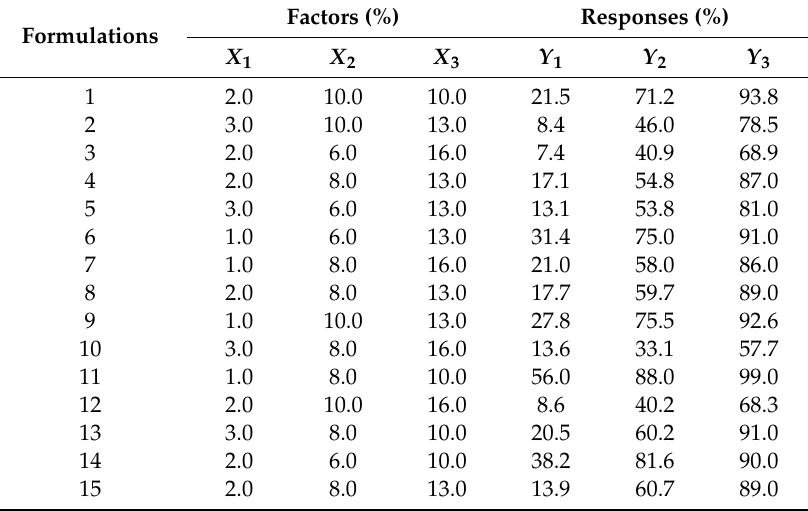
Table 2. Independent variables and observed responses of the Box-Behnken